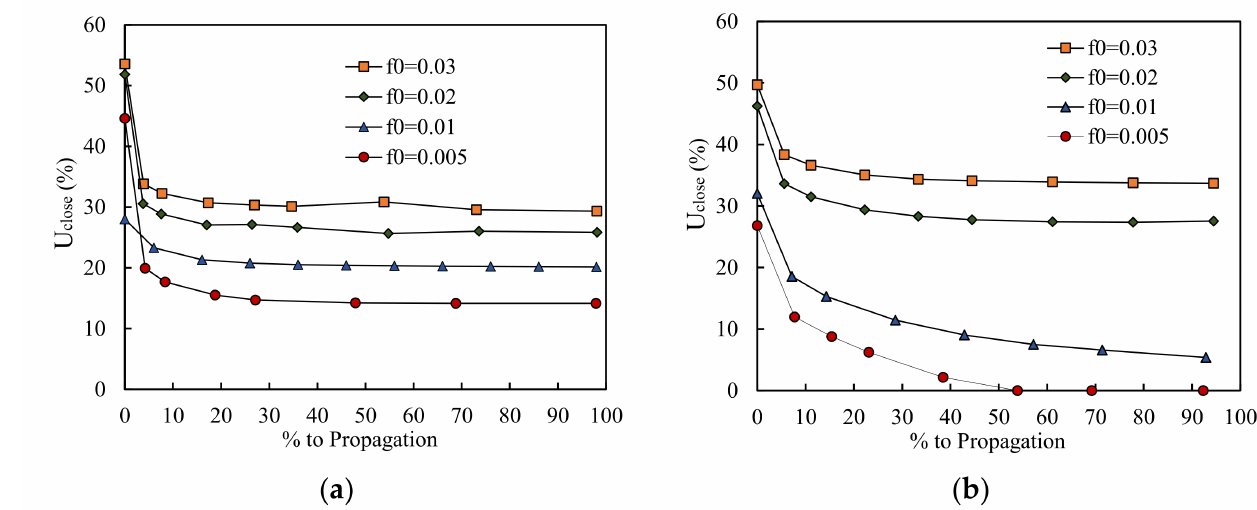
Figure 7. Crack closure level for: ( a ) a 0 = 11.5 mm ( b ) a 0 = 19